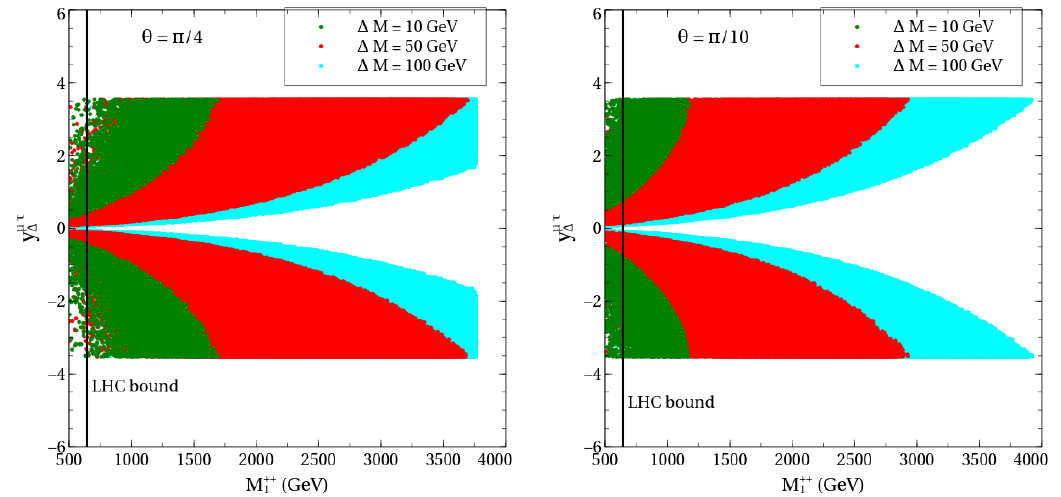
y (cid:22)(cid:28) 1 (cid:0) (cid:1) 1